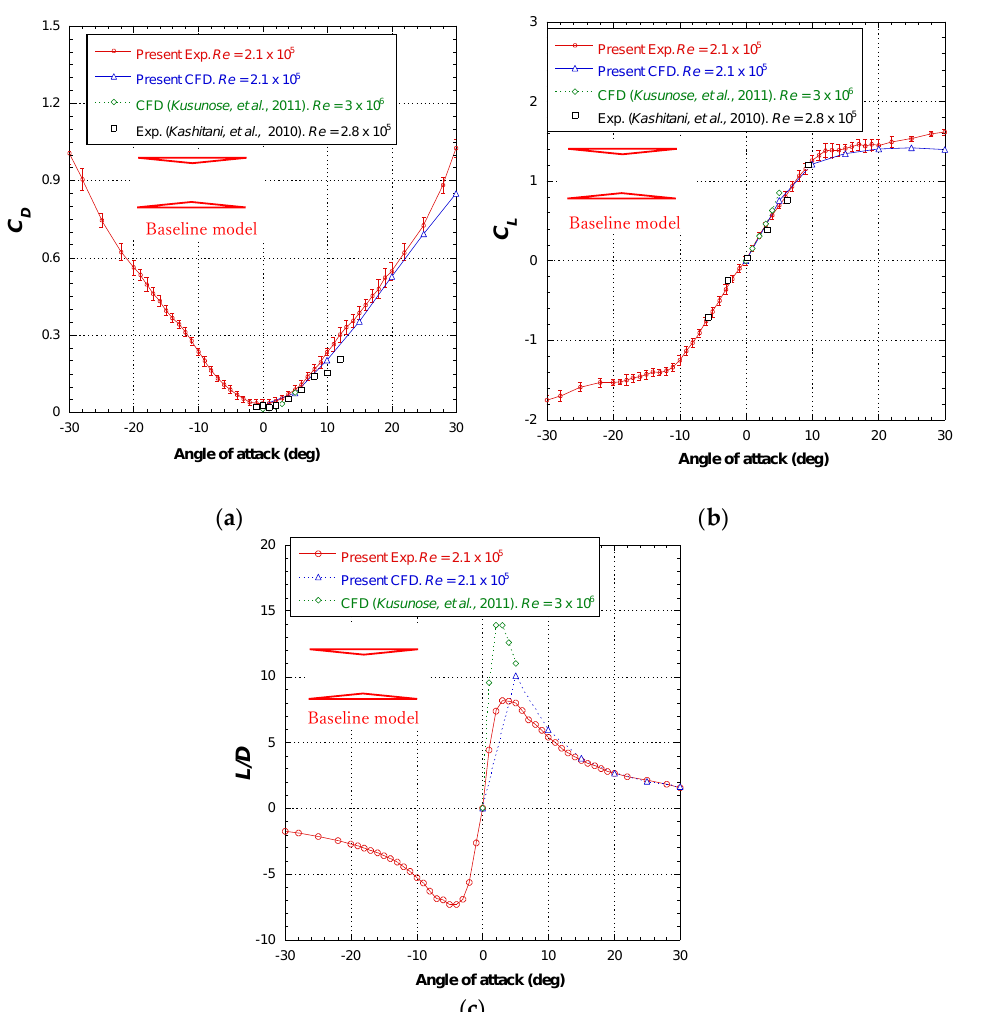
Figure 6. Aerodynamic characteristics of the baseline model: ( a ) drag coefficient; ( b ) lift coefficient; ( c ) lift-to-drag ratio. Table 2. Lift slopes of the baseline model. Exp. CFD Ref. [16] Ref. [17] Lift slopes ( ± 10 deg.) 0.129